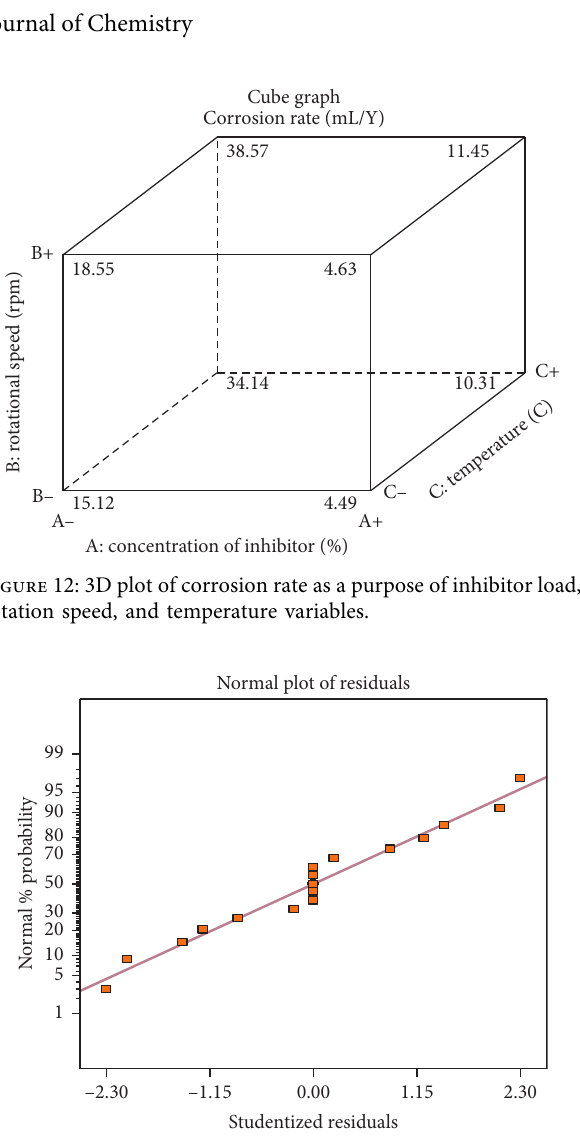
Figure 13: Normal plot of error distribution for corrosion